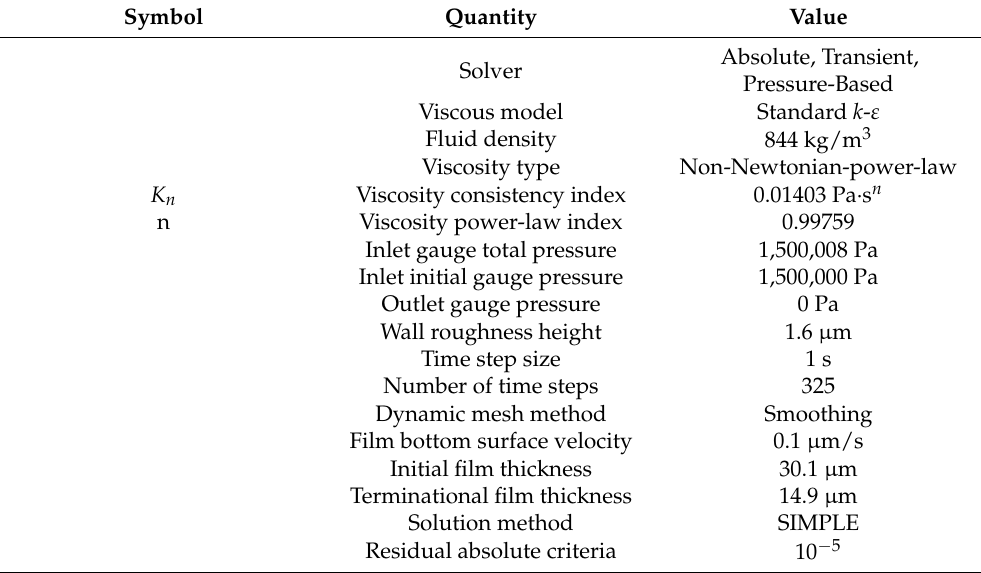
Table 2. Detailed boundary conditions and input